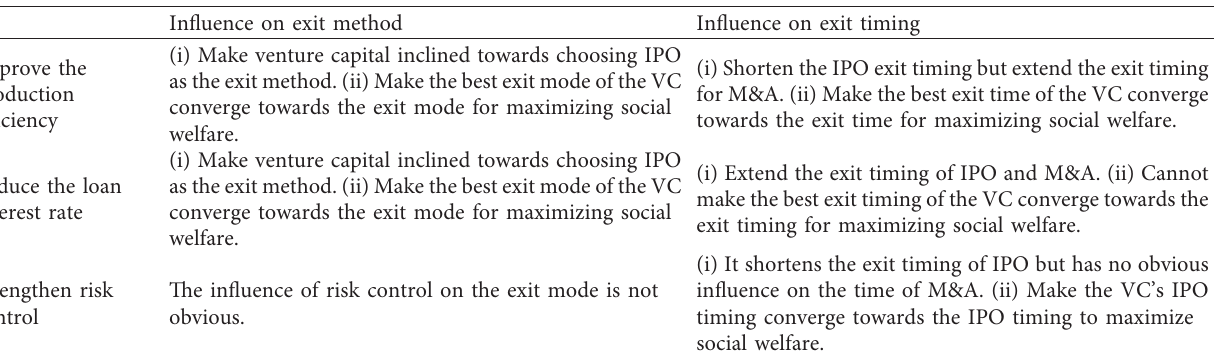
Table 3: Summary of numerical simulation results.